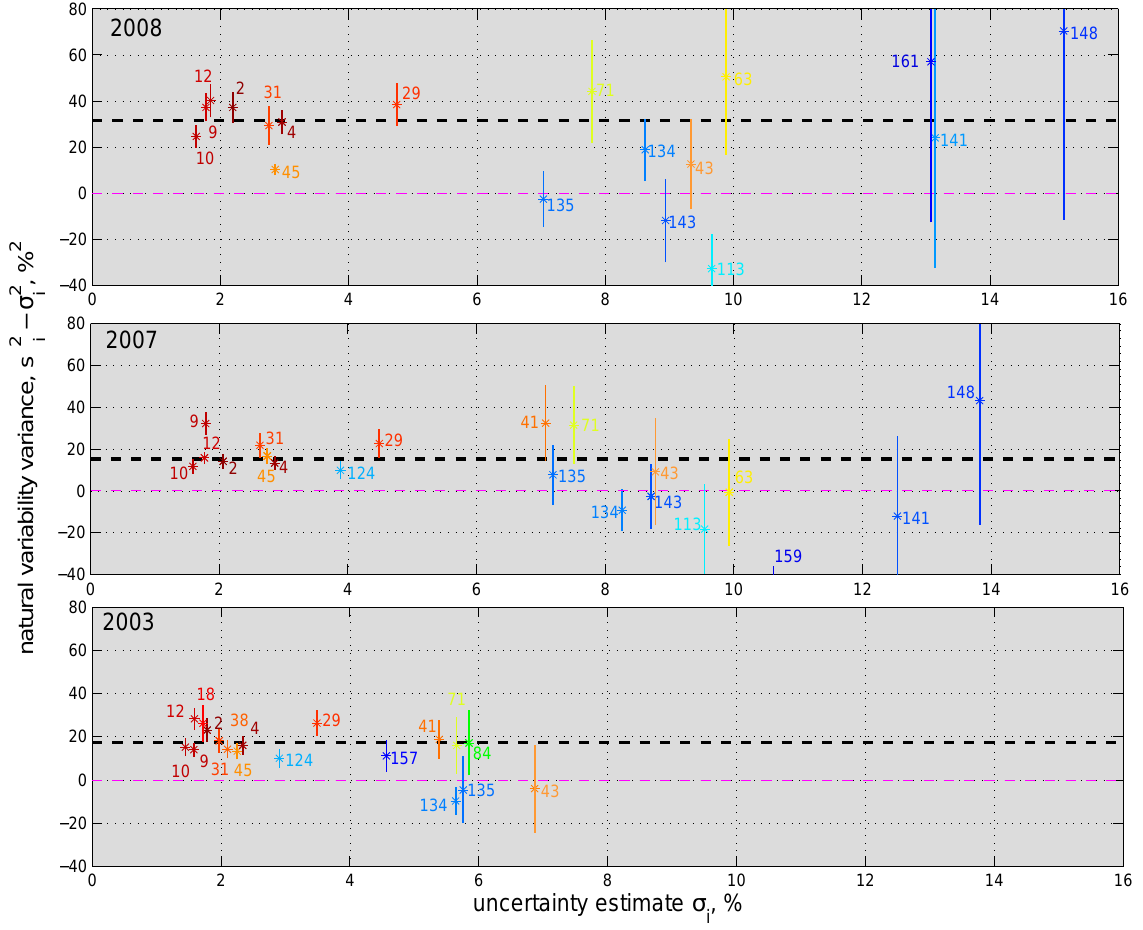
− σ 2 Figure 5. Estimates of natural variability variance ˆ σ 2 nat = s 2 at altitudes 25–40km for different stars plotted as a function of precisions i i σ i . Star numbers in GOMOS catalogue are indicated. Colors indicate star magnitude: from red for bright stars (small magnitude, small star number) to blue for dim stars (large magnitude, large star number). The error bars are 2 σ uncertainty intervals. Dashed lines indicate the mean natural variability estimates obtained using seven brightest stars. Magenta lines highlight